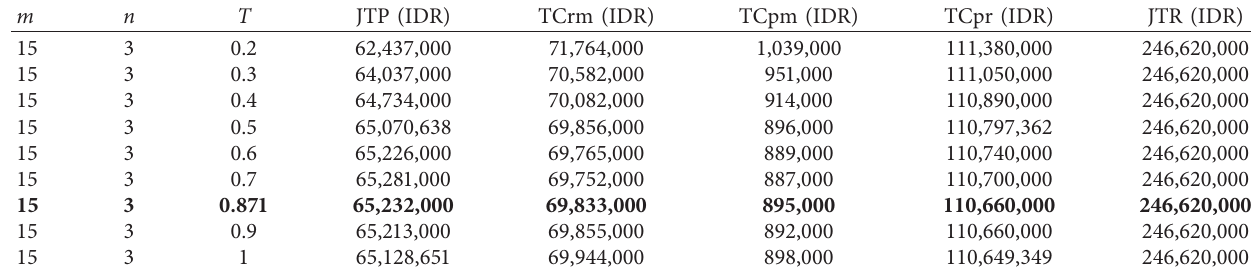
Table 5: Sensitivity analysis of the effect of T on cost, revenue, and profit.